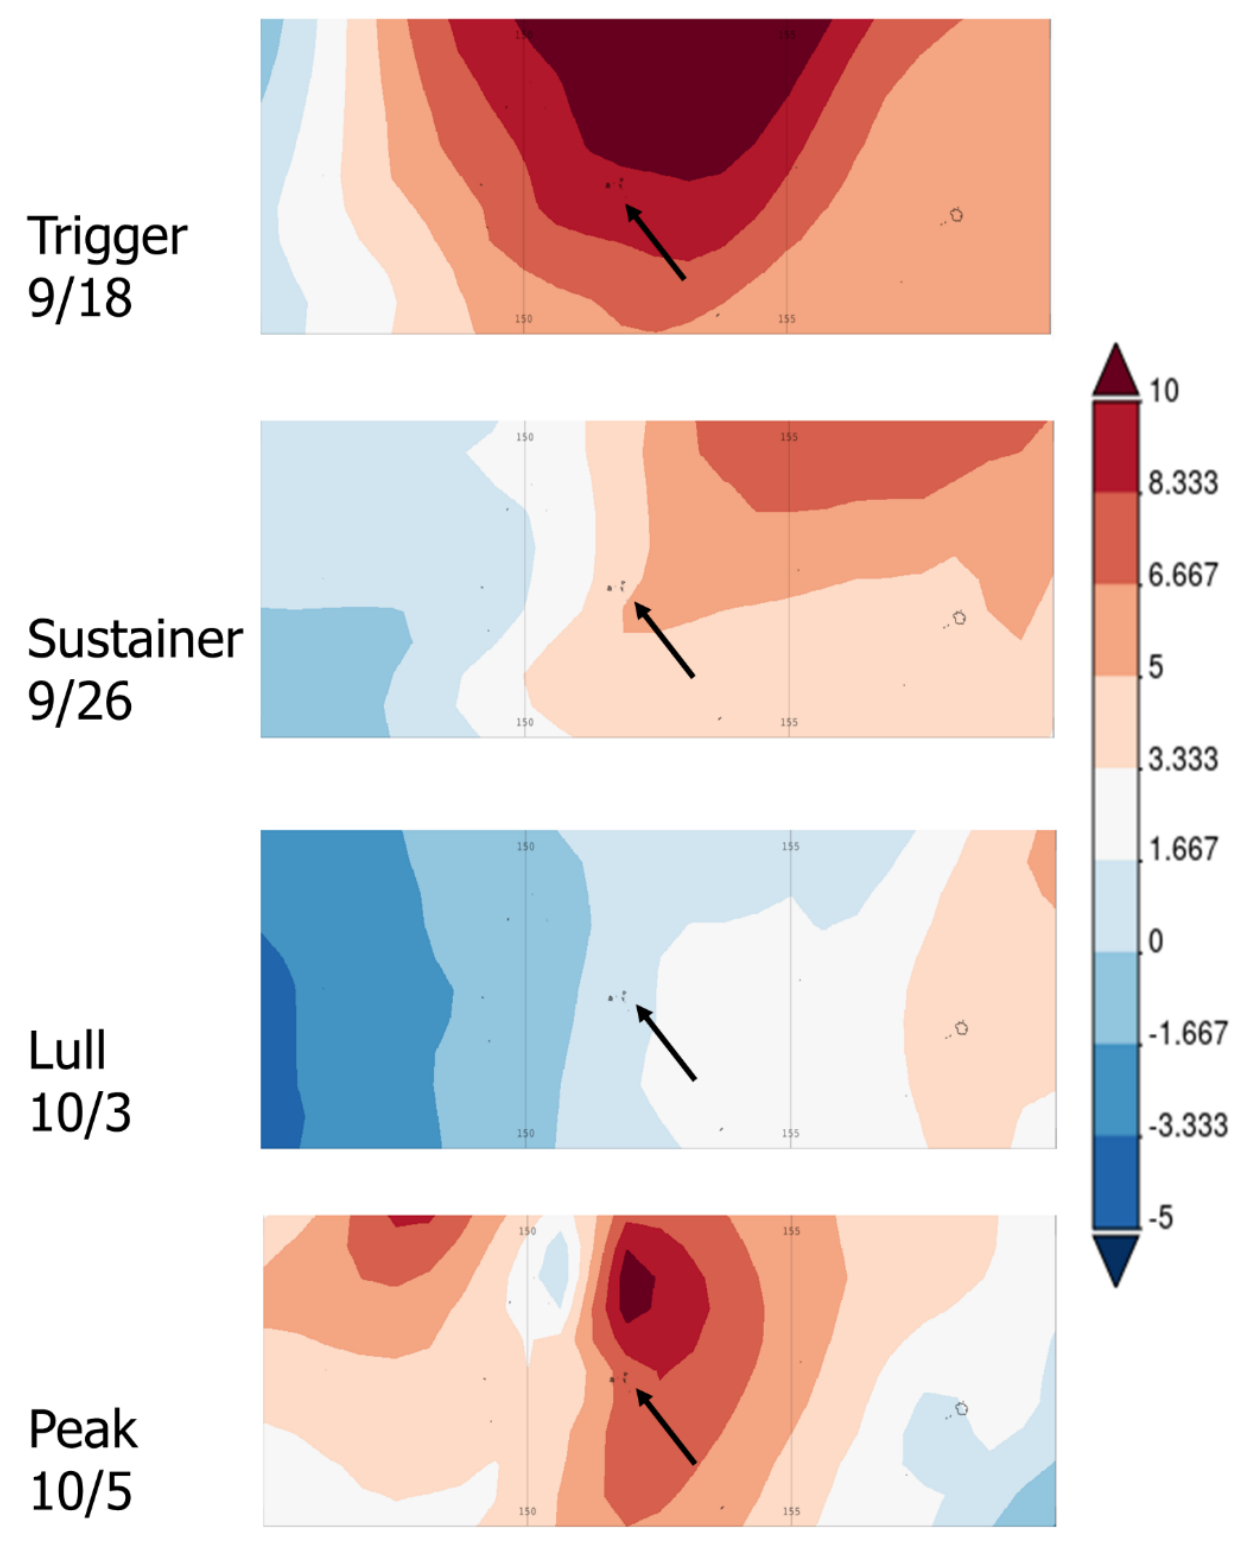
Figure 11. Time-averagedmaps of MERRA-2 instantaneous northward wind for the four events of the wind sequence described for the October 2013 bloom event. The location of Chuuk Lagoon is indicated with the arrow. The region shown is 145–160 ◦ E, 5–10 ◦ N. Units are m/s.